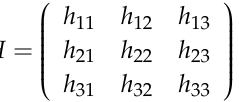
Figure 5. Representative captured images from drone-mounted cameras for mono panorama generation.